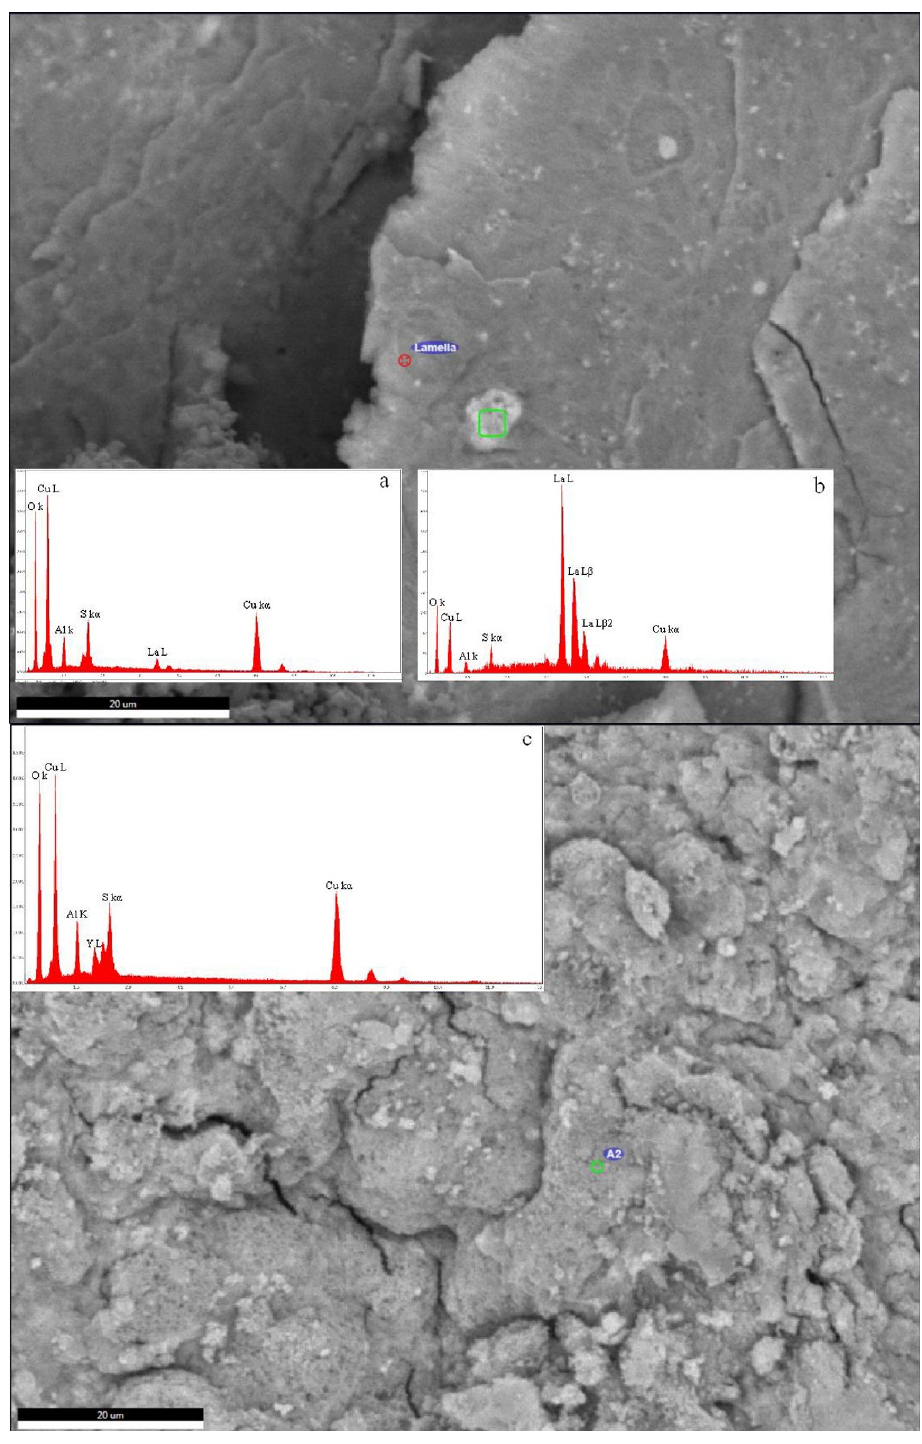
Figure 9. SEM image of LDH-La-10 (above) and LDH-Y-10 (below). In the insets the EDS semi-quantitative analyses are reported. ( a ) Analysis of the spot indicated in the LDH-Y-10 image; ( b ) analysis of the bright area in green in the LDH-La-10 image; and ( c ) analysis of the spot indicated in the LDH-La-10 image.